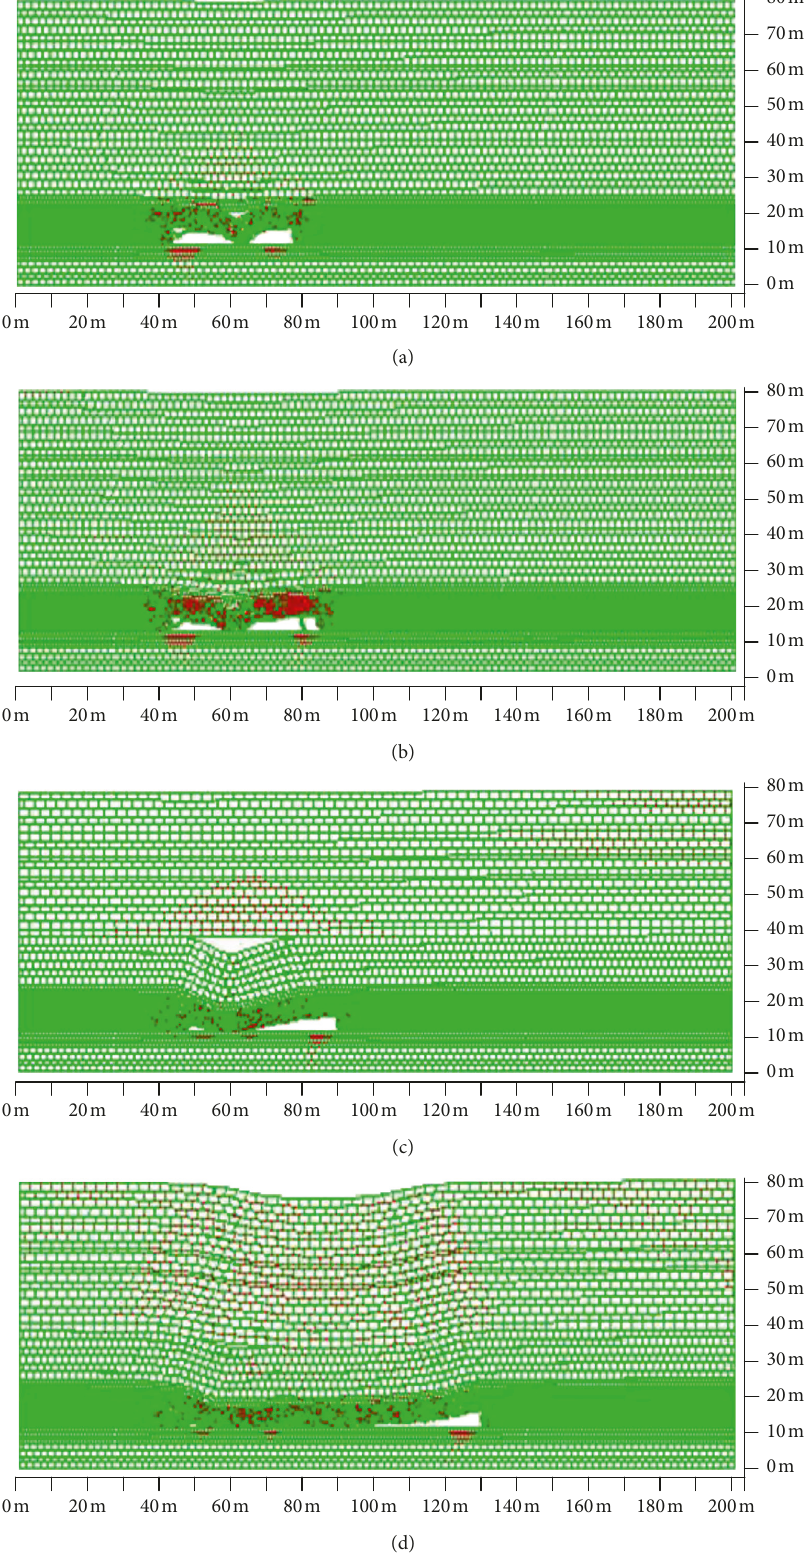
Figure 4: Movement law of the overburden strata when two hard rocks exist: advancing distances of the working face are (a) 35m, (b) 45m, (c) 50m, and (d)